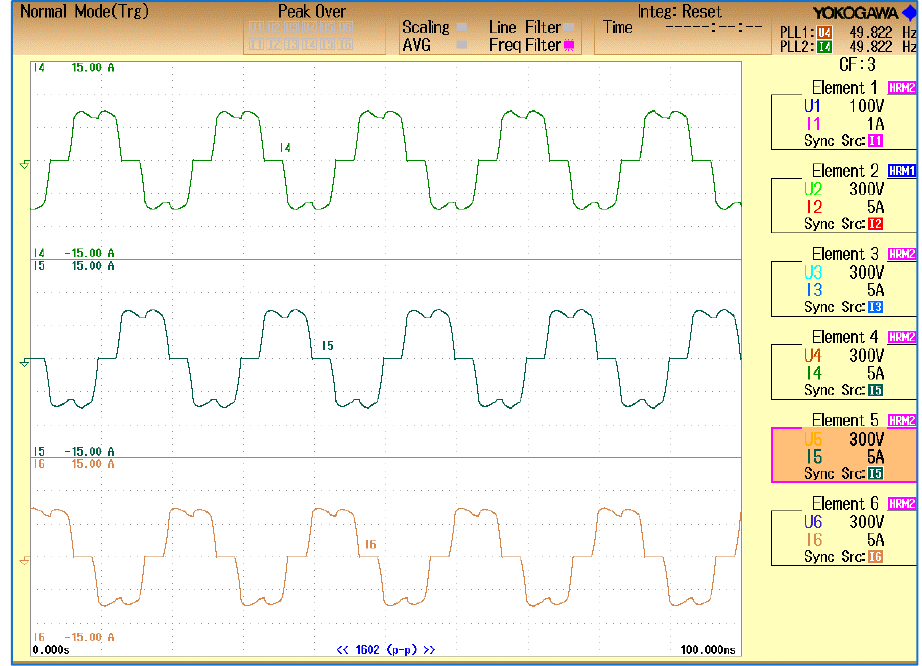
Figure 16. Load currents of the three phases.